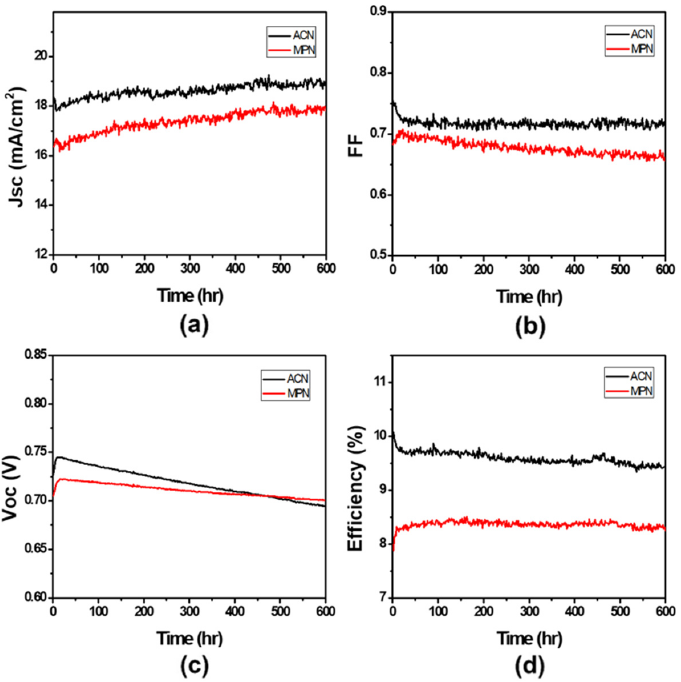
Figure 7. Time evolution of the ( a ) J SC , ( b ) FF, ( c ) V OC and ( d ) efficiency of a 5 cm × 5 cm C-DSSC module under continuous one-sun light soaking at 60 °C and 60 RH%.